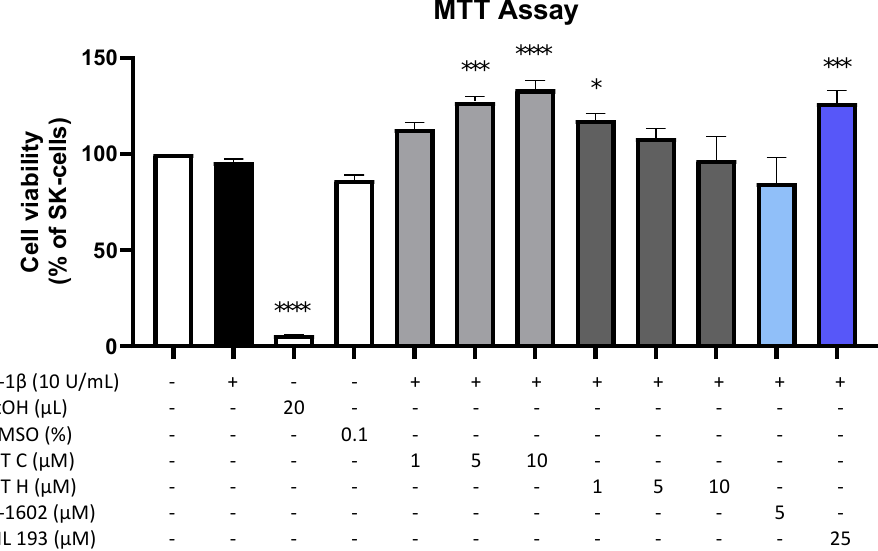
Figure 1. Effects of KIT C (light grey bars), KIT H (dark grey bars), O-1602 (light blue bar), and ML 193 (blue bar) on cell viability in IL- 1β -stimulated SK-N-SH cells (24 h treatment). Cell viability was measured by change in color due to MTT-oxidation, and absorbance was measured at 595 nm using an ELISA-reader. Values are presented as the mean ± SEM of at least three independent experiments. Statistical analysis was performed using one-way ANOVA with Dunett’s post hoc tests with * p < 0.05, *** p < 0.001, **** p < 0.0001 compared to untreated cells. The figure is derived from our previous publication